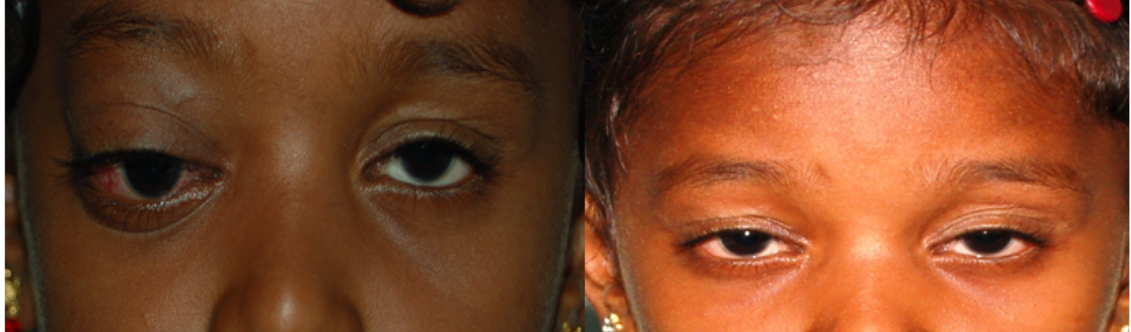
Figure 4: showing pre- and post-treatment (intravascular coiling) with complete resolution of proptosis, and other symptoms of carotid-cavernous fistula after two